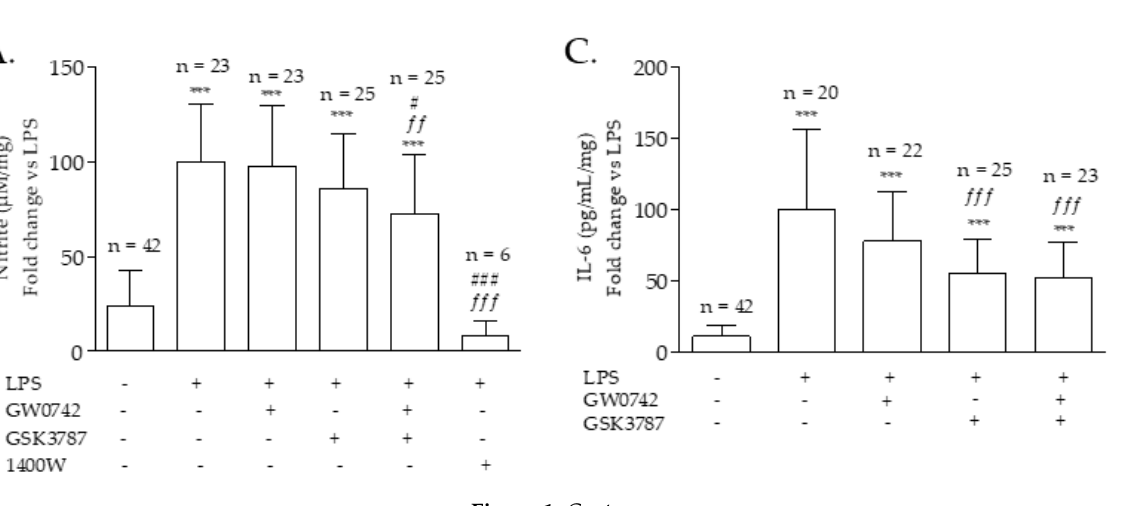
Figure 1. Nitrite (a marker for NO release) and IL − 6 production by pulmonary artery. Rat pulmonary artery rings were treated with two combinations of PPAR β / δ agonist-antagonist and iNOS inhibitor 1400W: ( A – C ) 100 nM GW0742—1 μ M GSK3787—100 μ M 1400W ( B – D ) 1 μ M L − 165041—1 μ M GSK0660—100 μ M 1400W. NO and IL − 6 production was measured after 24 h